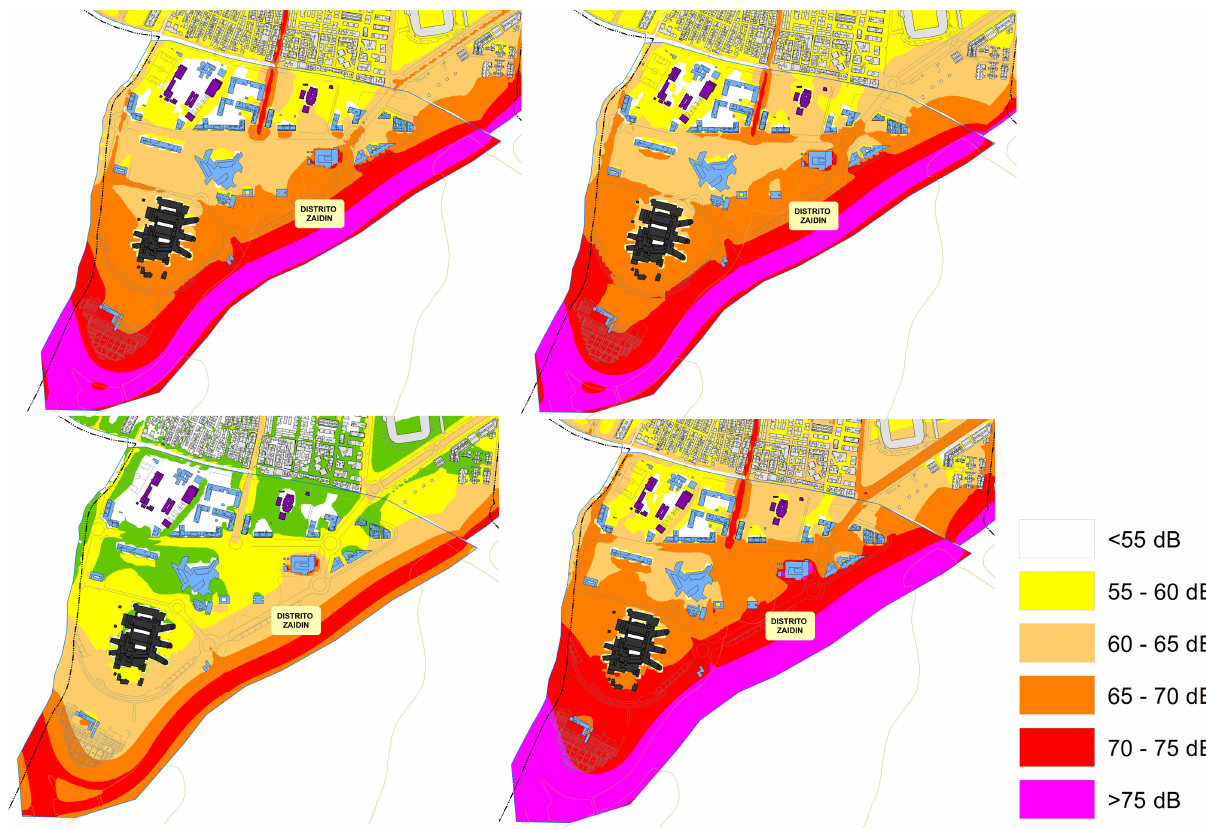
Figure 3: Study area environmental noise extracted from Granada 2016 Strategic Noise Map. From left to right, up to down: Ld (dBA), Le (dBA), Ln (dBA) and Lden